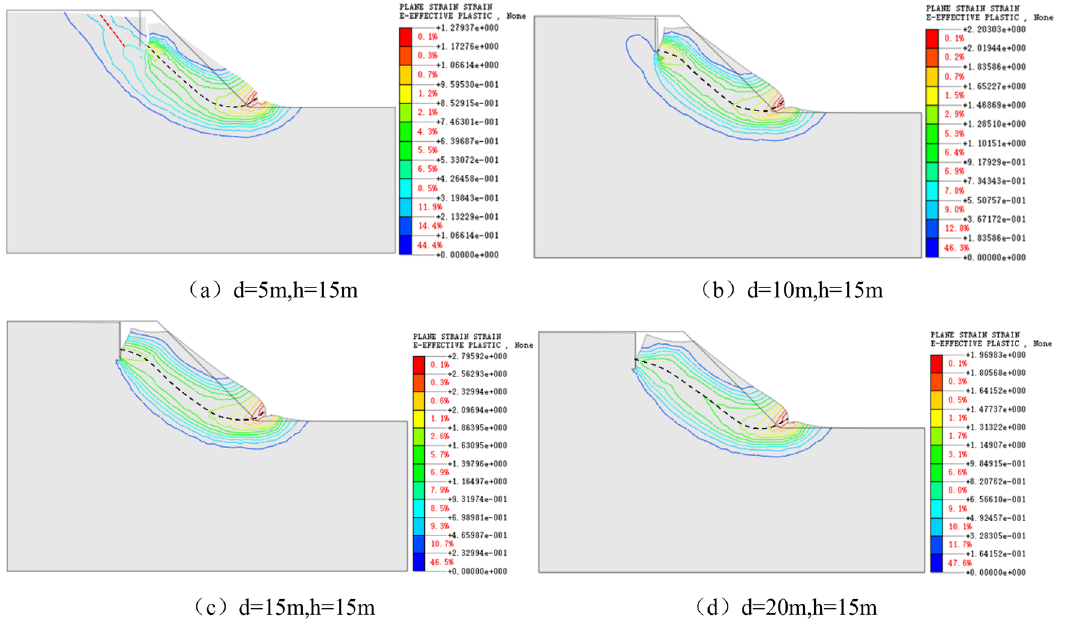
Figure 8. Cloud chart of the plastic zone and sliding surface at the back edge of landslide with dip angle β = 30°–65°.